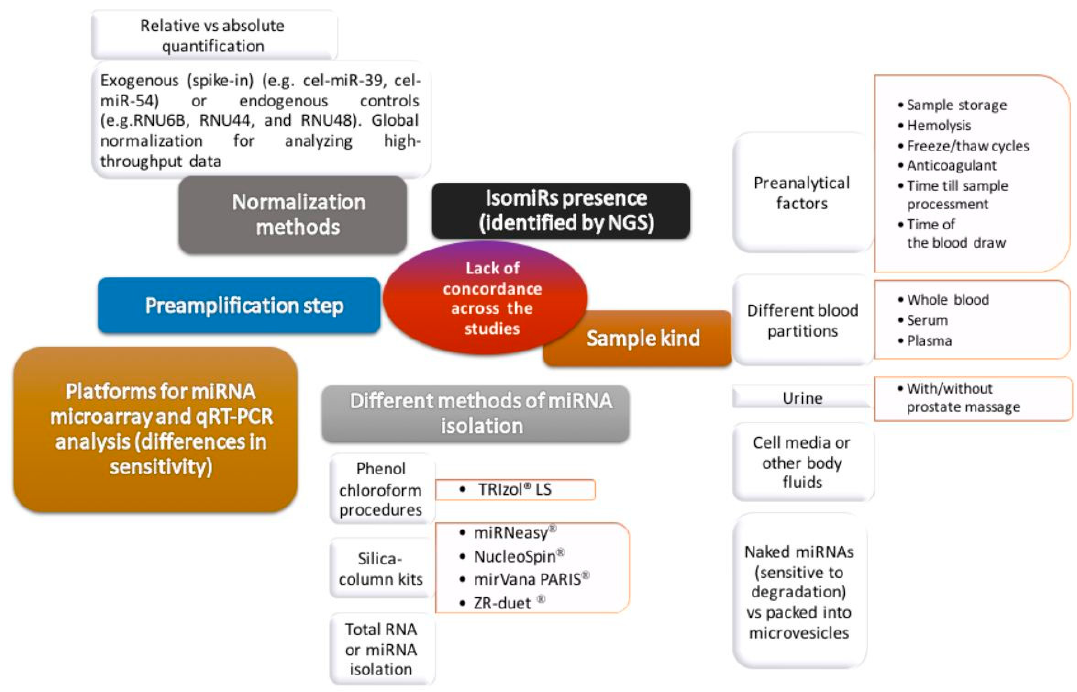
Figure 5. Sources of lack of concordance across the different studies. miRNA: microRNA, NGS: next generation sequencing.